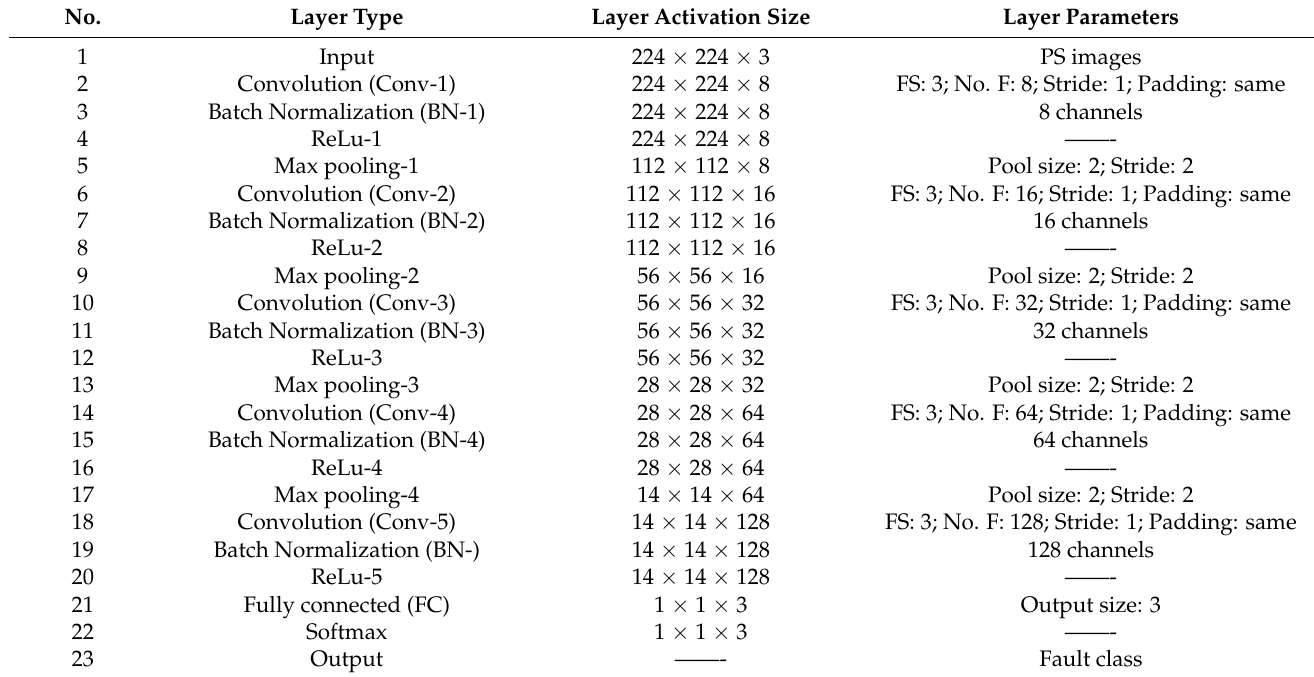
Figure 8. Details of the CNN. Table 2. Detailed information of the CNN layers.